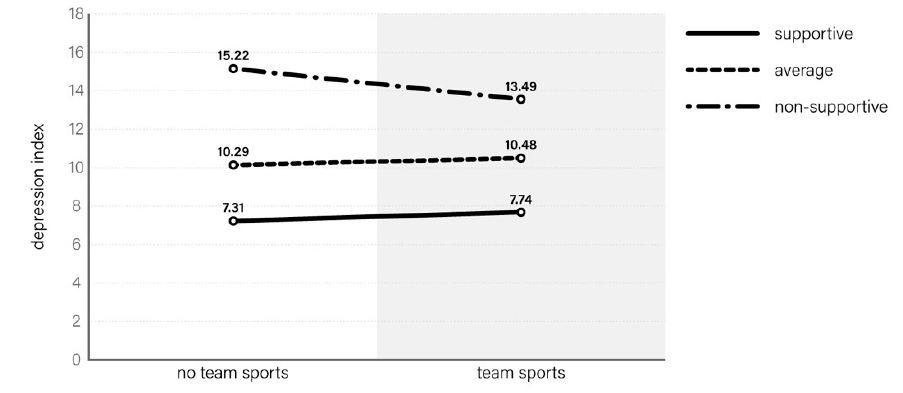
Figure 2. Depression level among students according to team sport participation and growing-up